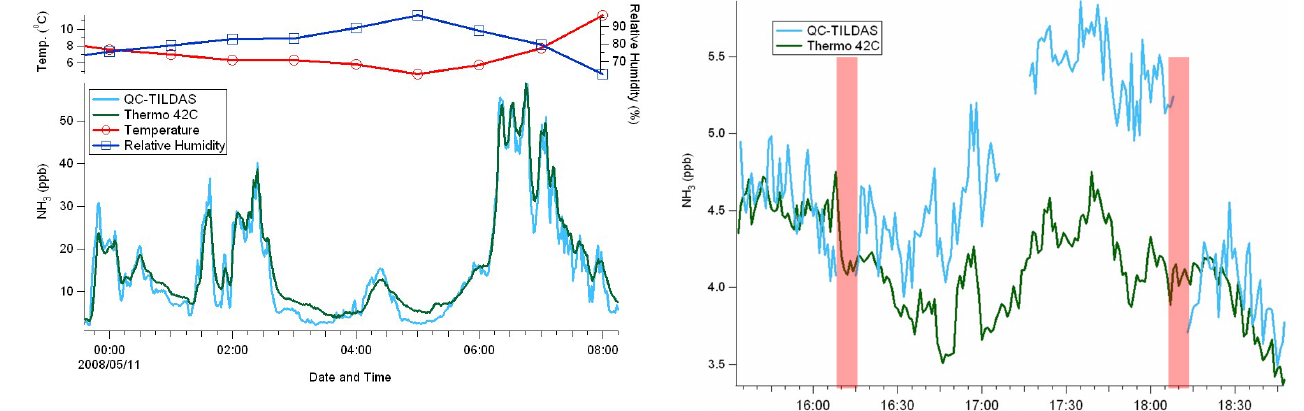
Fig. 7a. Time series of CARE observations of temperature and rel- ative humidity and the response of the QC-TILDAS and Thermo 42CTL, both averaged to one minute. The inlet used for the QC- TILDAS results in a faster response to changes in ambient NH 3 mixing ratio.